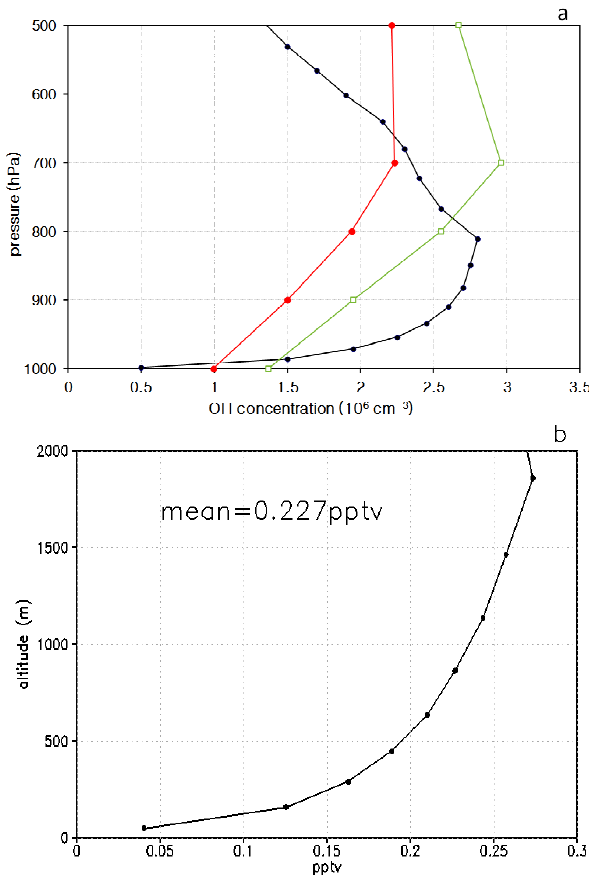
Fig. 4. (a) OH concentration averaged on the 10 days of the BG1 simulation (including night time periods) as a function of pressure (black), climatological 3-D-computed zonally and monthly averaged OH concentration on October at − 12 ◦ S (green) (Spivakovsky et al., 2000) and climatological 3-D-computed mean zonally averaged OH concentration on January, April, July and October at − 12 ◦ S (red) (Spivakovsky et al., 2000), (b) OH mixing ratio averaged on the 10 days of the BG simulation (including only day time periods) as a function of altitude. The mean value in the 0–2km layer is indicated in the figure.